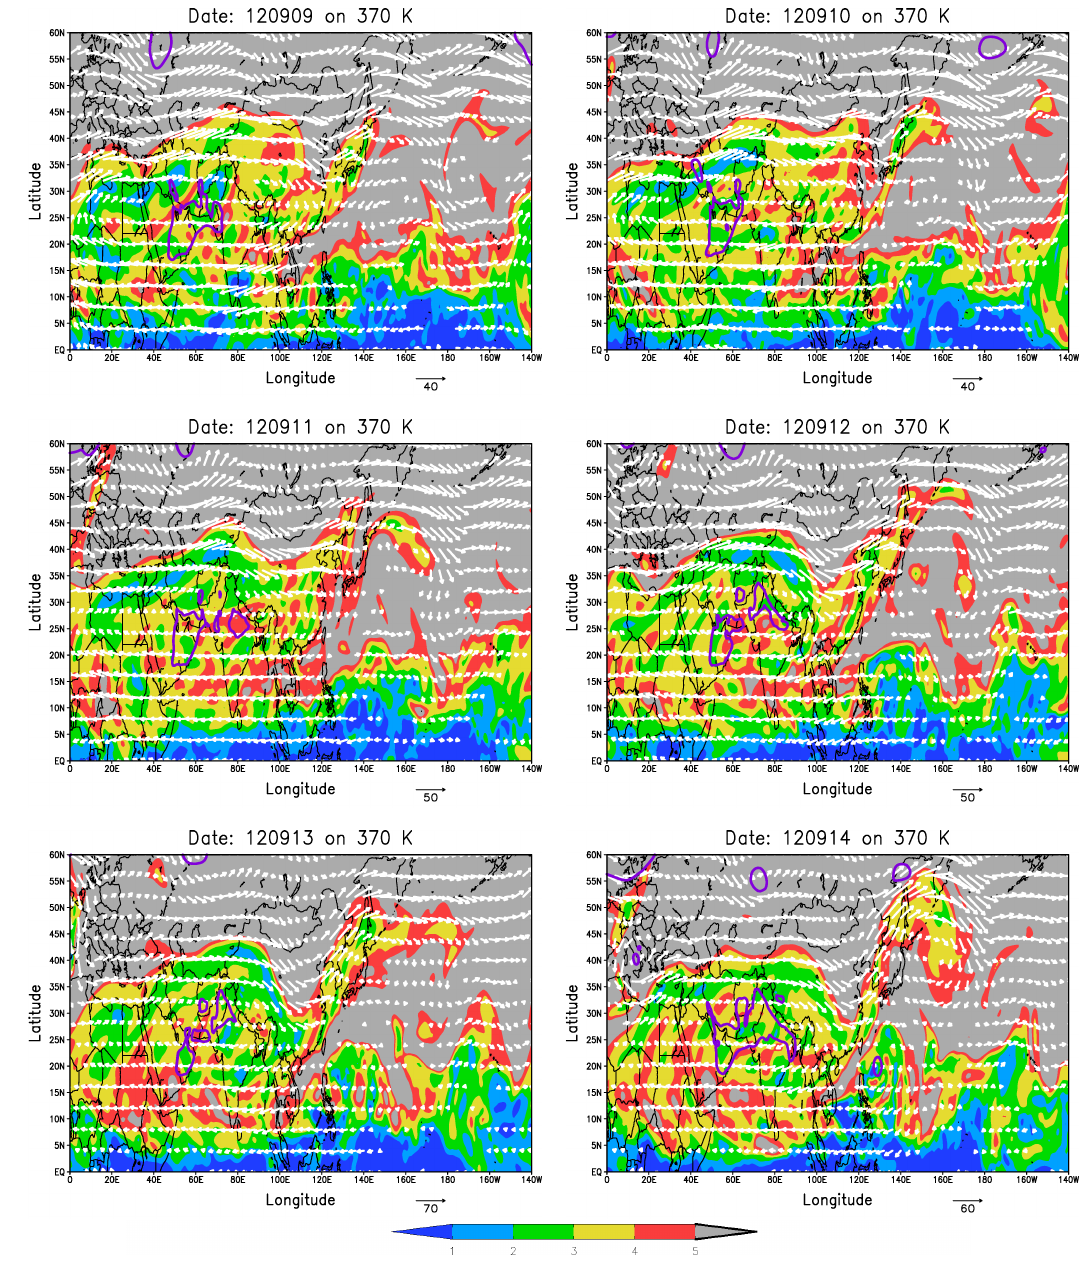
Fig. 7. Time sequence of PV fields (colour shading in PVU) over Asia at 370K potential temperature from 9 to 20 September 2012 based Figure on ERA-Interim reanalysis data. The horizontal winds are indicated by white arrows. To show the position of tropospheric low-pressure systems in particular the super typhoon Sanba (e.g. 20 ◦ N 130 ◦ E on 14 September, 25 ◦ N 130 ◦ E on 15 September, 30 ◦ N 130 ◦ E on ≈ ≈ ≈ 16 September, and 40 ◦ N 130 ◦ E on 17 September) the sea level pressure of 1000hPa is marked as a thick purple line. ≈